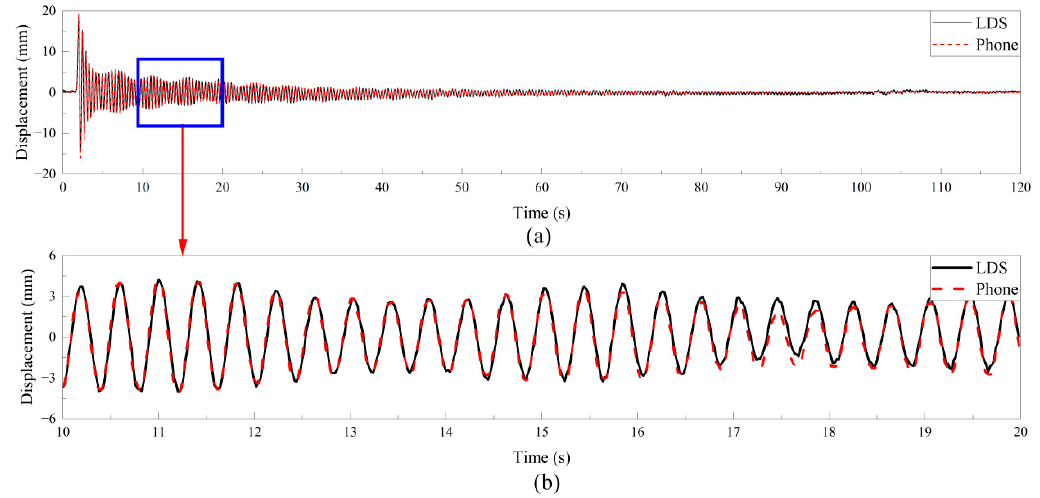
Figure 19. Comparison of displacement time history of telephoto lens for smartphone assembly: ( a ) Whole displacement time history; ( b ) 10~20 s displacement time history.